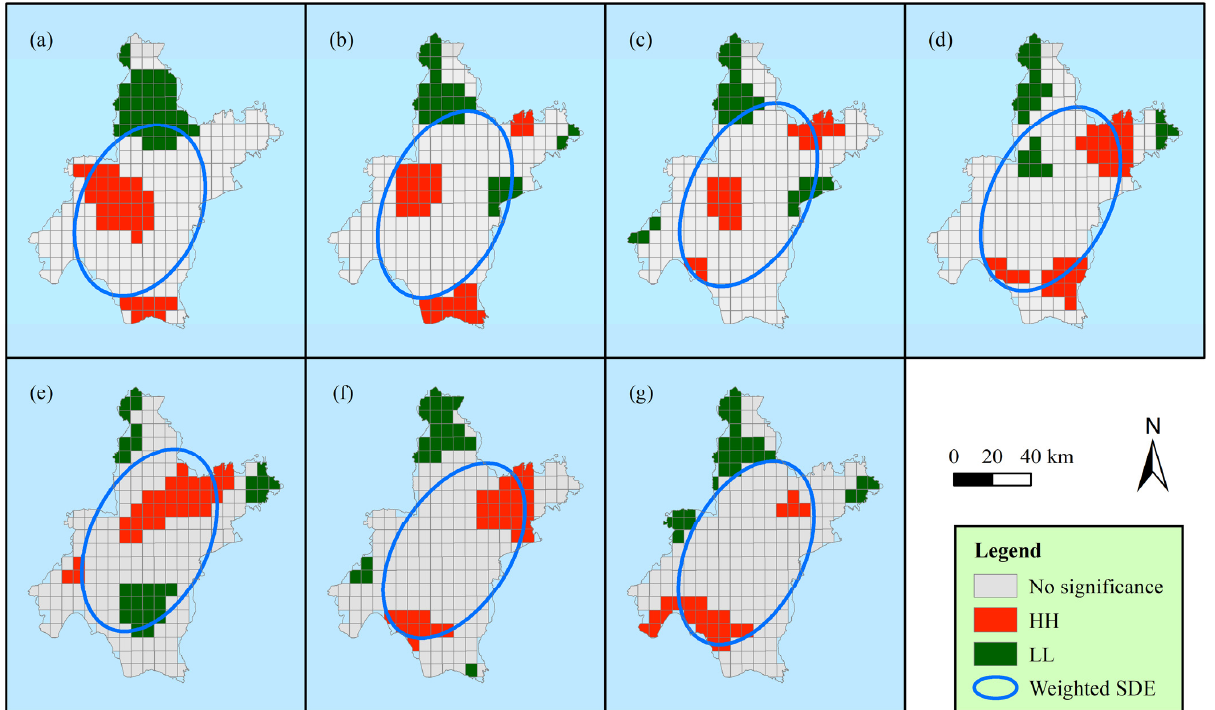
Figure 7. Local spatial pattern of the air temperature at 14:00 (significant level at 0.05). ( a ) 17 July;